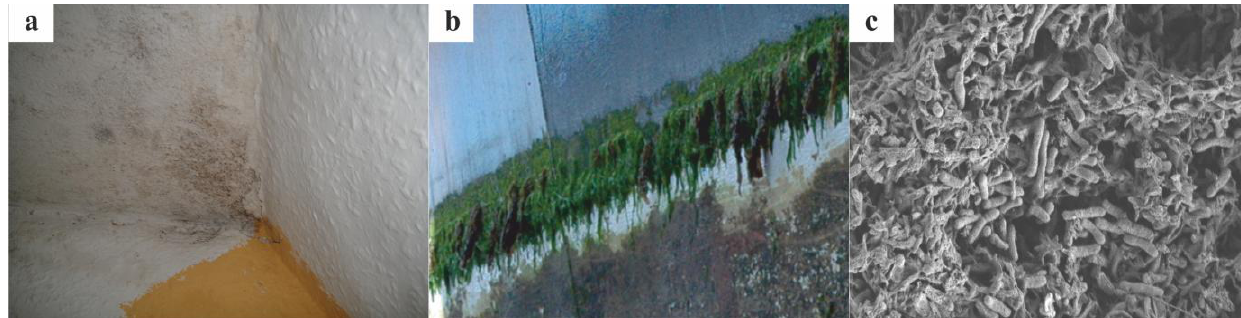
Figure 1. Typical biofilms: ( a ) mold in households, ( b ) algae growth on a ship’s hull, ( c ) bacterial biofilm on a